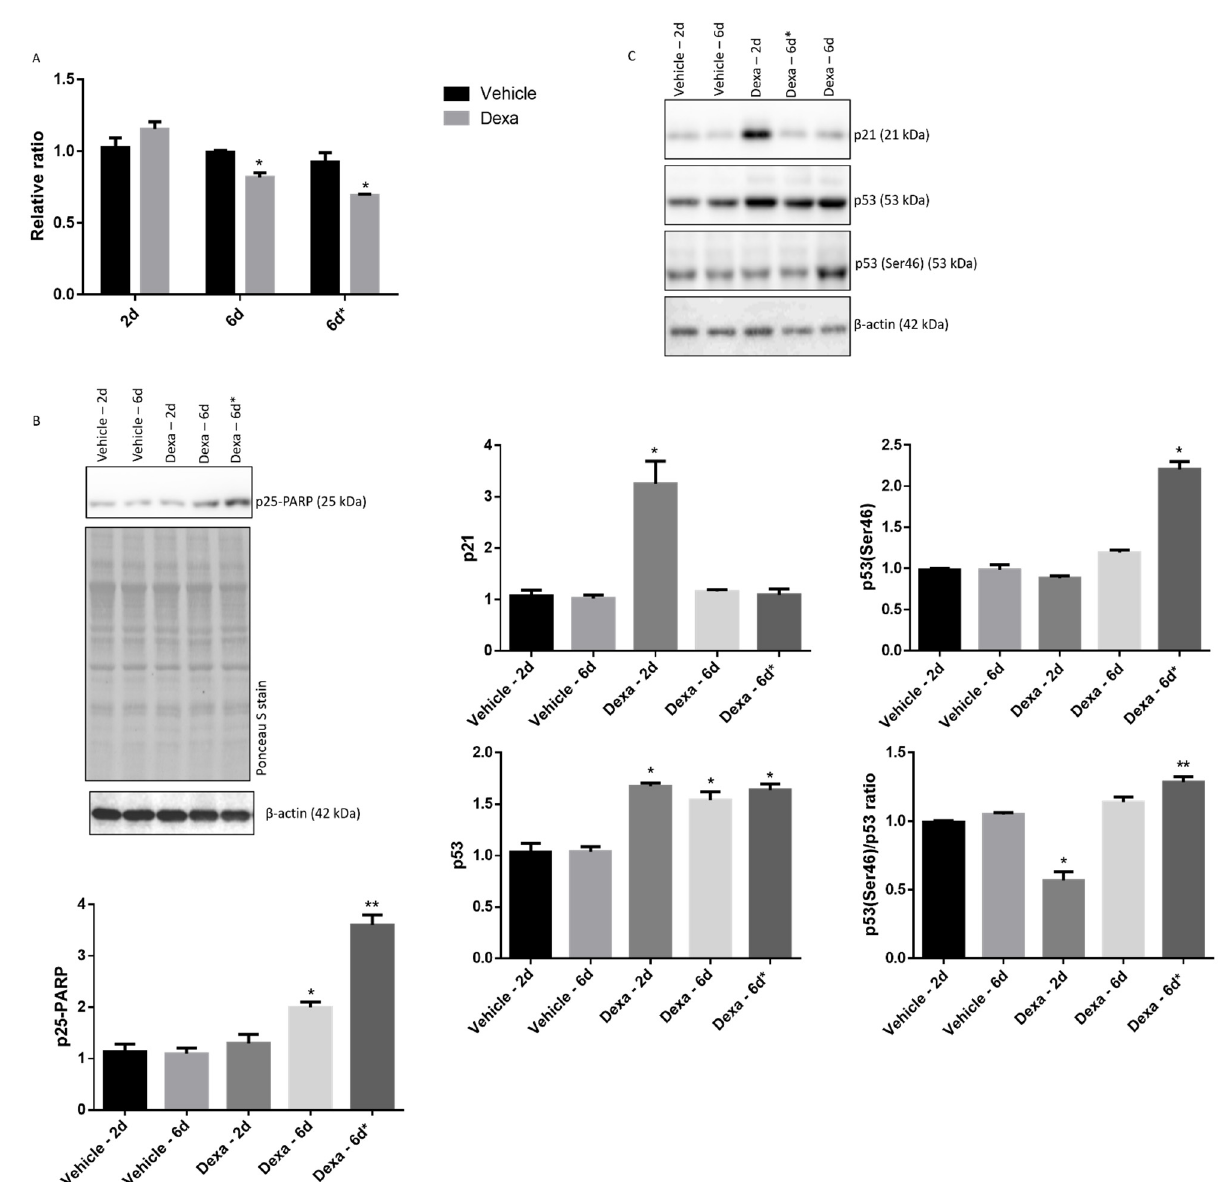
Figure 1. Reduced growth and apoptosis in TMCs repeatedly stimulated with Dexa. ( A ) TMCs were seeded at the same dilution (3 wells for each experimental condition) and challenged with vehicle or Dexa following the scheme and dosage indicated. At selected timepoints, cell proliferation and viability were assessed by MTT assay. A nominal value of 1 was assigned to the O.D. of the first vehicle well. A representative experiment of two independent observations is reported ( n = 3). Comparisons have been run between Dexa and correspondent vehicle cells at each timepoint. * p < 0.005, unpaired τ Student’s test. ( B ) Immunodetection of the p25 fragment of PARP in whole cell lysates by Wb. Although β -actin pattern is shown, normalization was performed on total proteins (Ponceau S stain). A representative experiment of three independent observations is reported ( n = 3) * p < 0.04, ** p < 0.0008. ( C ) Immunodetection of the p21, p53, phospho-p53(Ser46) and determination of the phospho-p53(ser46)/p53 ratio in whole cell lysates by Wb. Normalization was performed on β -actin. A representative experiment of three independent observations is reported ( n = 3) * p < 0.0001; ** p < 0.008; one-way ANOVA followed by Tukey’s post hoc significance